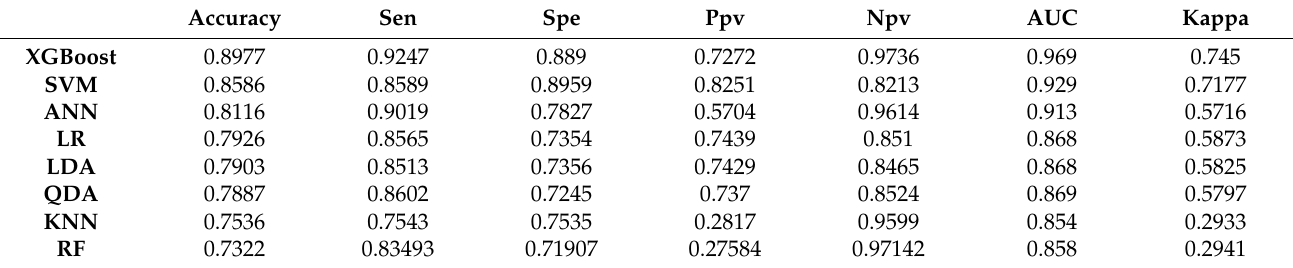
Table 4. Assessment of eight machine learning models.